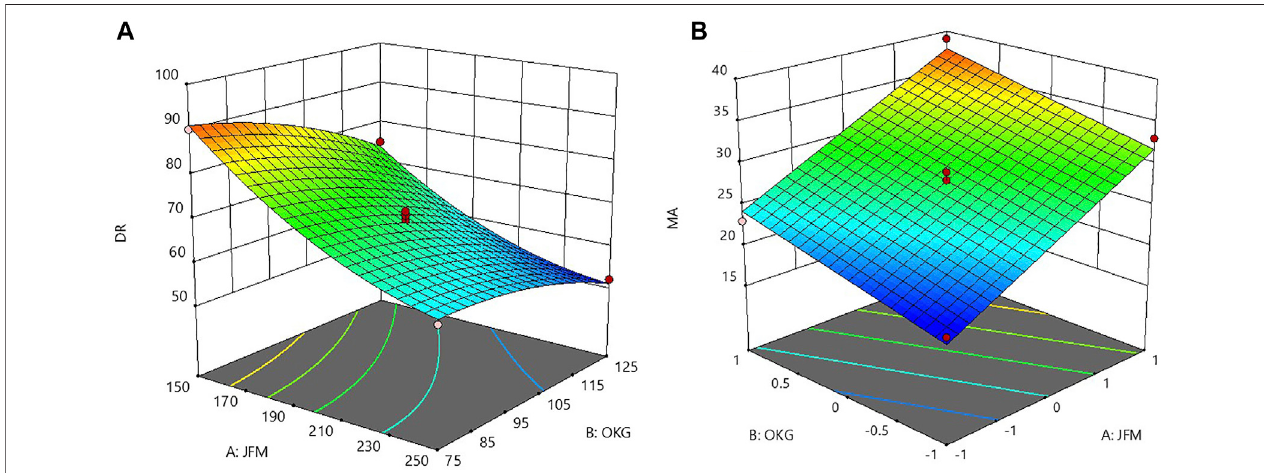
FIGURE 4 | 3D response surface plots showing the combined effect of JFM-OKM on (A) % CDR at 12 h and (B) MA.